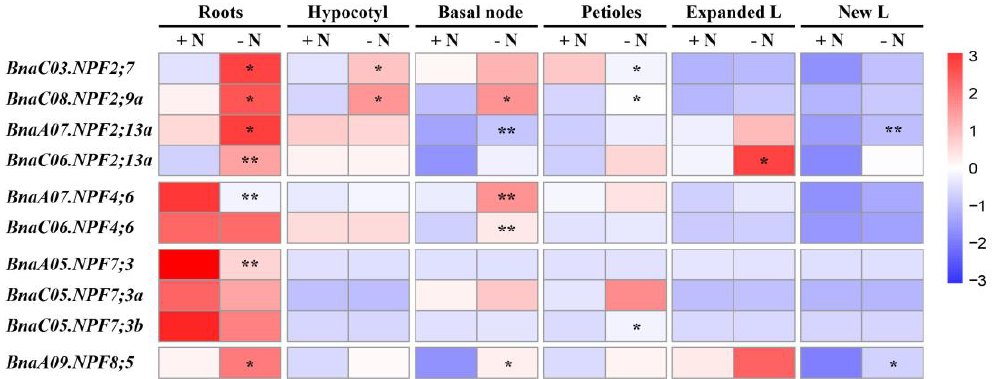
Figure 8. The expression profiles of the 10 core BnaNPF genes in different tissues under nitrogen (N) stress by quantitative Real-Time PCR (qRT-PCR). Seedlings of 14 days’ old were exposed to N-free nutrient solution for six days. The roots, hypocotyl, basal node, petioles, fully expanded leaves (expanded L) and new leaves (new L) were sampled separately for RNA extraction. CK, normal nutrient supply; LN, N stress (0 µ M N) condition. The color scale was shown on the right side. The heat map was generated using TBtools after data normalization (Z-score). * and ** indicates significant di ff erence at P 0.05 and P 0.01 by student’s t test,